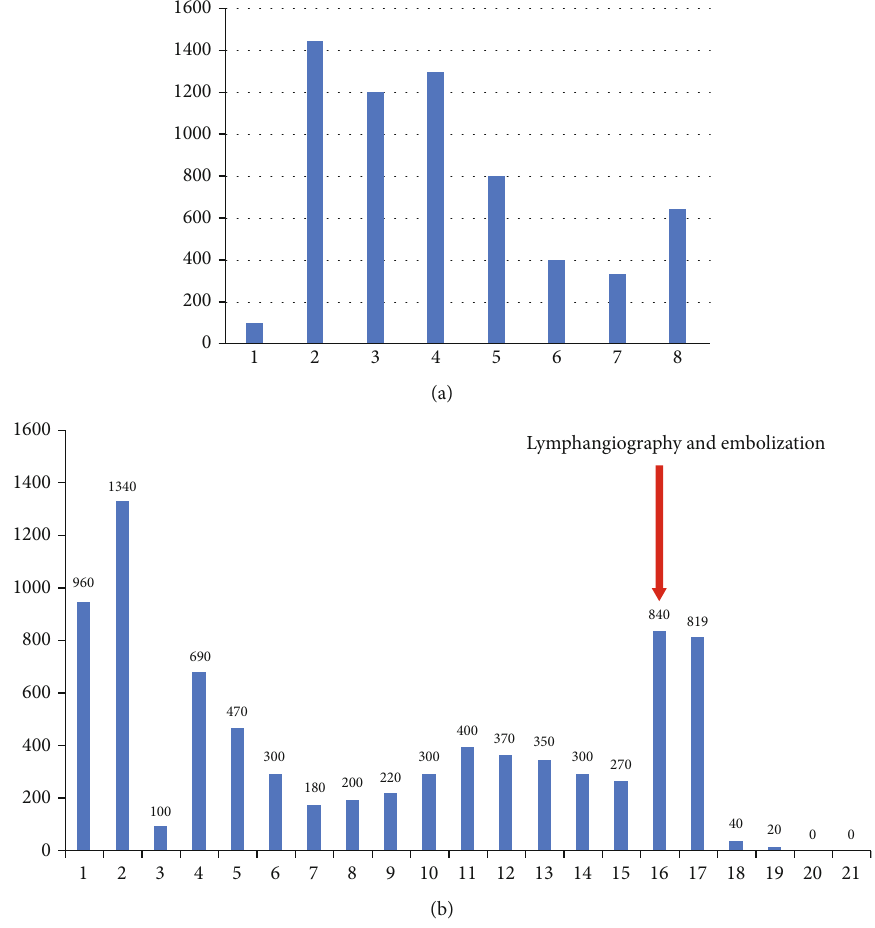
Figure 2: (a) Lymphatic fi stula output in the early postoperative period. (b) Lymphatic fi stula output after fi rst